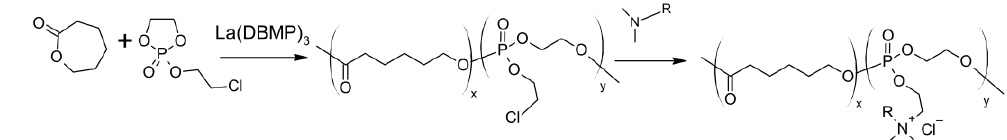
Figure 22. Synthesis of cationic poly(ester- co -phosphoester) with quaternary ammonium cation.